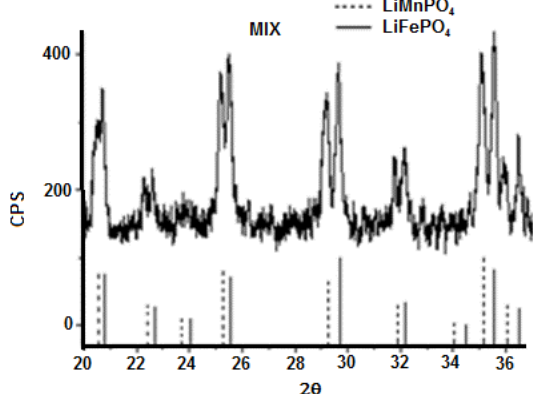
Figure 9. Comparison between X-ray Diffraction spectra of a binary mixture of LiFePO 4 and LiMnPO 4 and corresponding pure lithium metal phosphates. Table 3. Cell parameters and crystallite size.